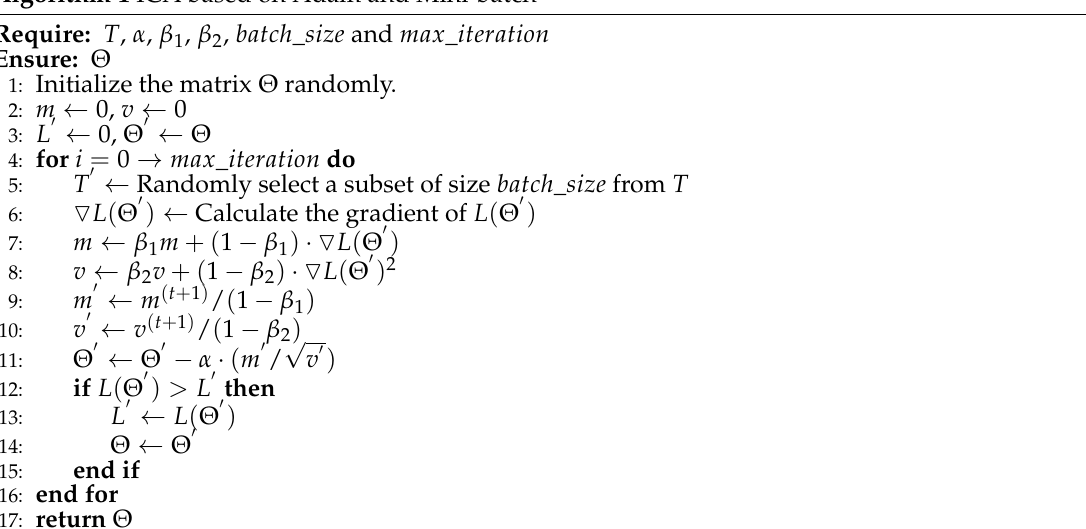
Algorithm 1 ICA based on Adam and